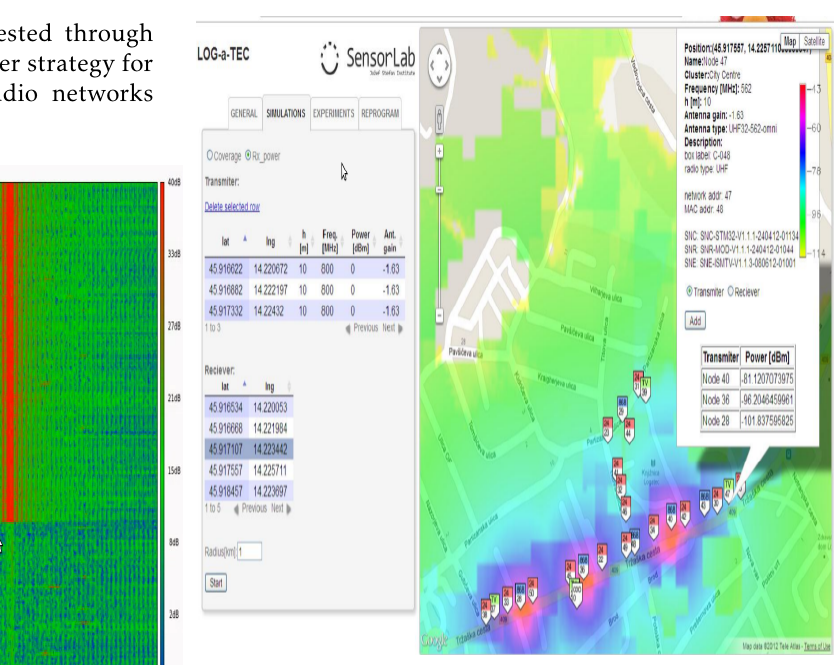
Figure 10. Platform for remote test on the TV